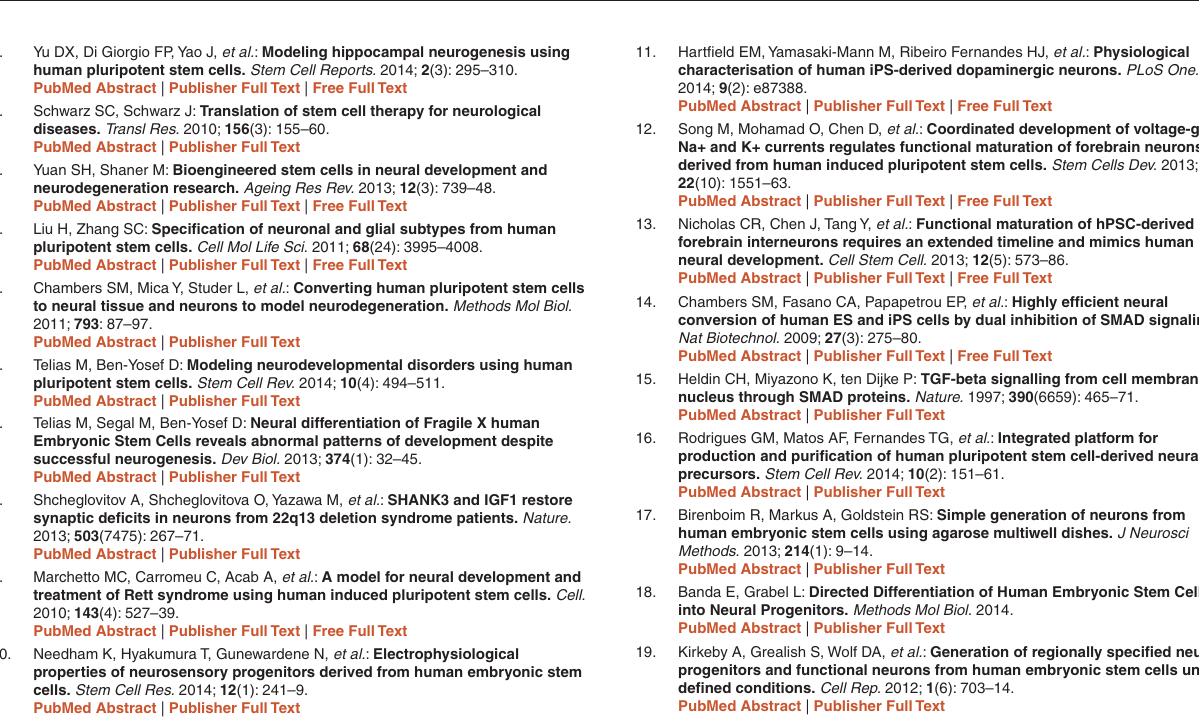
figshare: Data files electrical maturation of neurons derived from human embryonic stem cells doi: 10.6084/m9.figshare.1132475